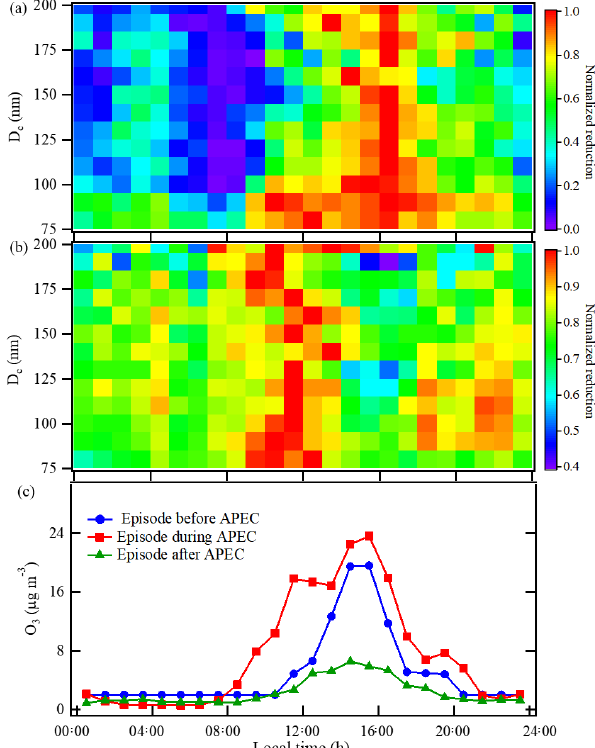
Figure 4. Diurnal cycle of the normalized reduction in the m NR − CM /m rBC ratio of BC-containing particles for the pollu- tion episode during APEC relative to those (a) before and (b) af- ter APEC. (c) Diurnal cycle of O 3 concentration for the pollution episodes before, during and after